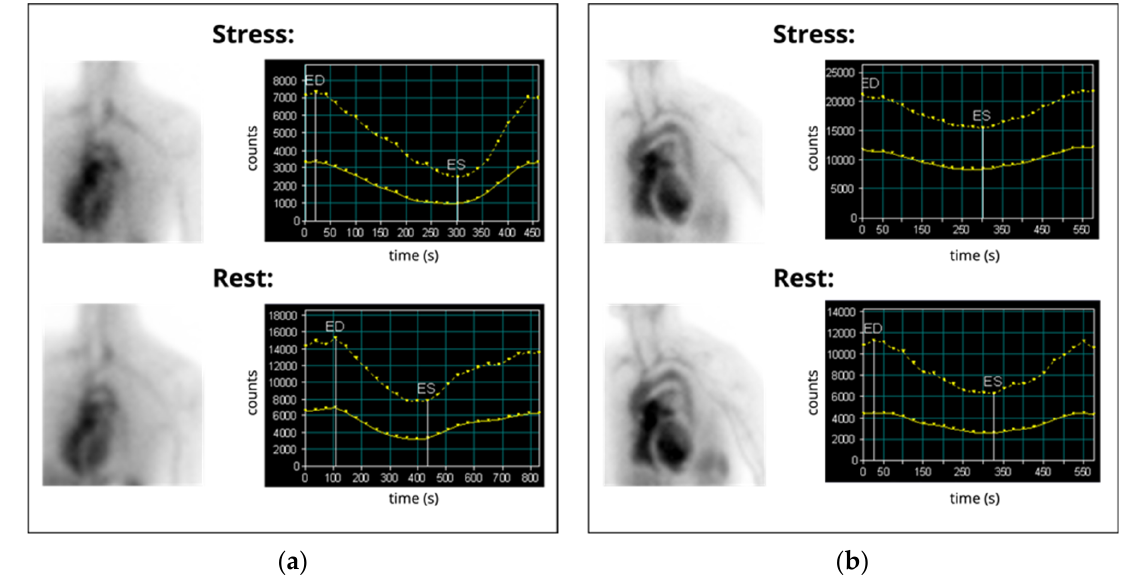
Figure 5. ( a ) Example of a physiological result in planar scintigraphy equilibrium radionuclide angiography: Normal LVEF and regular LVEF reaction to stress (rest: 56%, stress: 73%). ( b ) Example for a pathologic result: Decreased LFEF and inadequate LVEF reaction to stress (rest: 26%, stress: 24%). ED: end-diastolic, ES: end-systolic. Images were acquired at our institution.